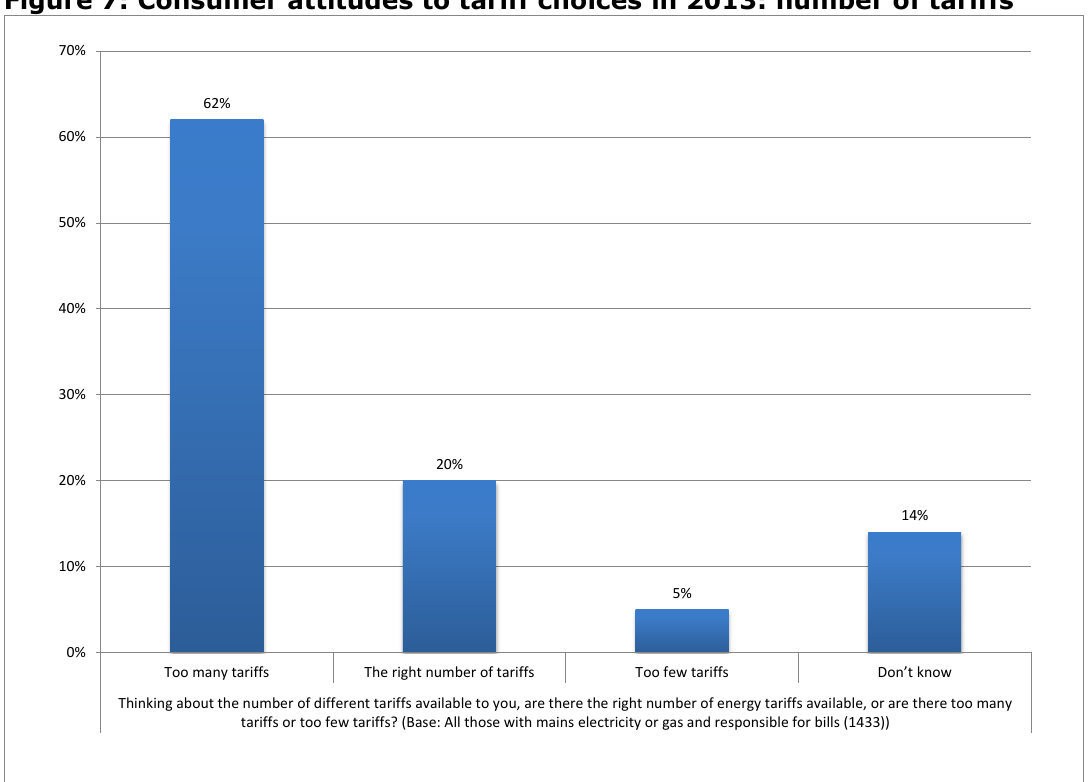
Figure 7: Consumer attitudes to tariff choices in 2013: number of